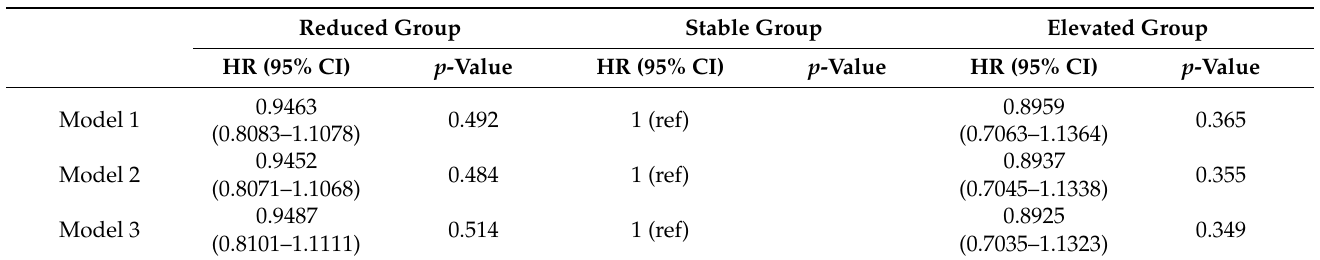
Table 5. Association of high-sensitivity C-reactive protein (Hs-CRP) change with incident cognitive impairment risk.